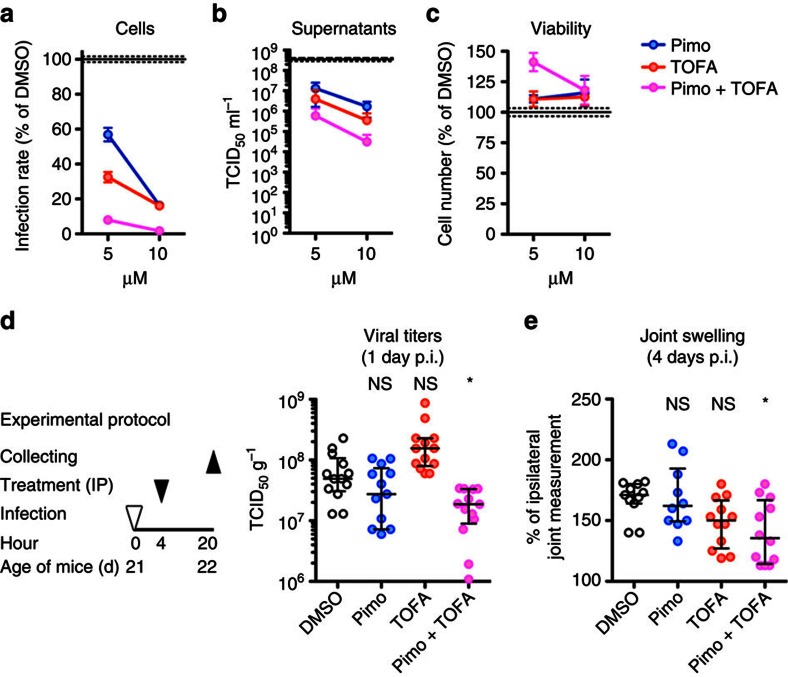
Impact of pimozide and TOFA combination on CHIKV replication in vitro and in vivo.(a–c) Infection rate (n=9 for all data sets at increasing concentrations; n=51 for DMSO) (a), supernatant titration (n=8 for all data sets at increasing concentrations; n=57 for DMSO) (b) and cell viability (c) of HEK-293T cells infected with CHIKV-GFP (MOI: 0.5) for 1 h, and then exposed to the indicated concentrations of antiviral drugs for 23 h. Solid and dashed black lines indicate the mean±s.e.m. of the DMSO control (pimo=pimozide). Data in a and c were measured by flow cytometry. (d) Experimental design of the footpad CHIKV infection model of adult mice used to measure the therapeutic effect on CHIKV replication of pimozide, TOFA or their combination (n=13 for all data set, one outlier for pimo is not shown in the graph but was considered for statistics). (e) Footpad swelling measured 4 days post infection in mice treated as in d (n=11, 10, 12 and 12 in displayed order). The experiment shown in e was repeated twice. All the other data were obtained from at least three independent experiments. Data in a,b and c are expressed as the mean±s.e.m. and in d and e are shown as the median±interquartile range; each dot represents one mouse. Statistics were calculated using the Kruskal–Wallis test with the Dunn's post test (*P<0.05; NSP≥0.05) NS, not significant.